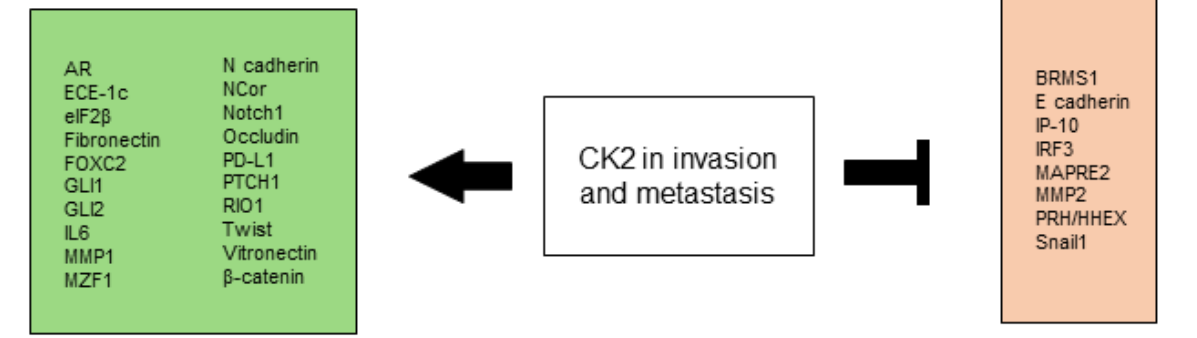
Figure 4. CK2-dependent modified proteins involved in invasion and metastasis. Proteins that are activated in this process by CK2 modification are shown on the left (highlighted in green), and proteins that are restricted in their function are shown on the right (highlighted in red).